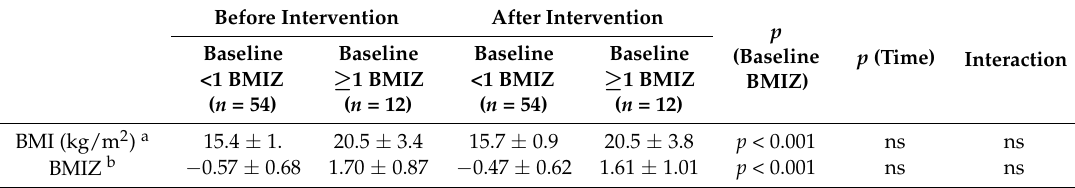
Figure 4. Comparison of body mass index (BMI) change after the 1-month intervention among different BMIZ ( z -score of BMI-for-age) groups based on the status at the baseline. The boxes represent the median (black middle line) limited by the 25th (Q1) and 75th (Q3) percentiles. The whiskers are the upper and lower adjacent values, which are the most extreme values within Q3 + 1.5 (Q3 − Q1) and Q1 − 1.5 (Q3 − Q1), respectively. The dots represent outliers. Table 5. Body mass index (BMI) and BMIZ ( z -score of BMI-for-age) of the children, divided into two groups at baseline, before and after the intervention.